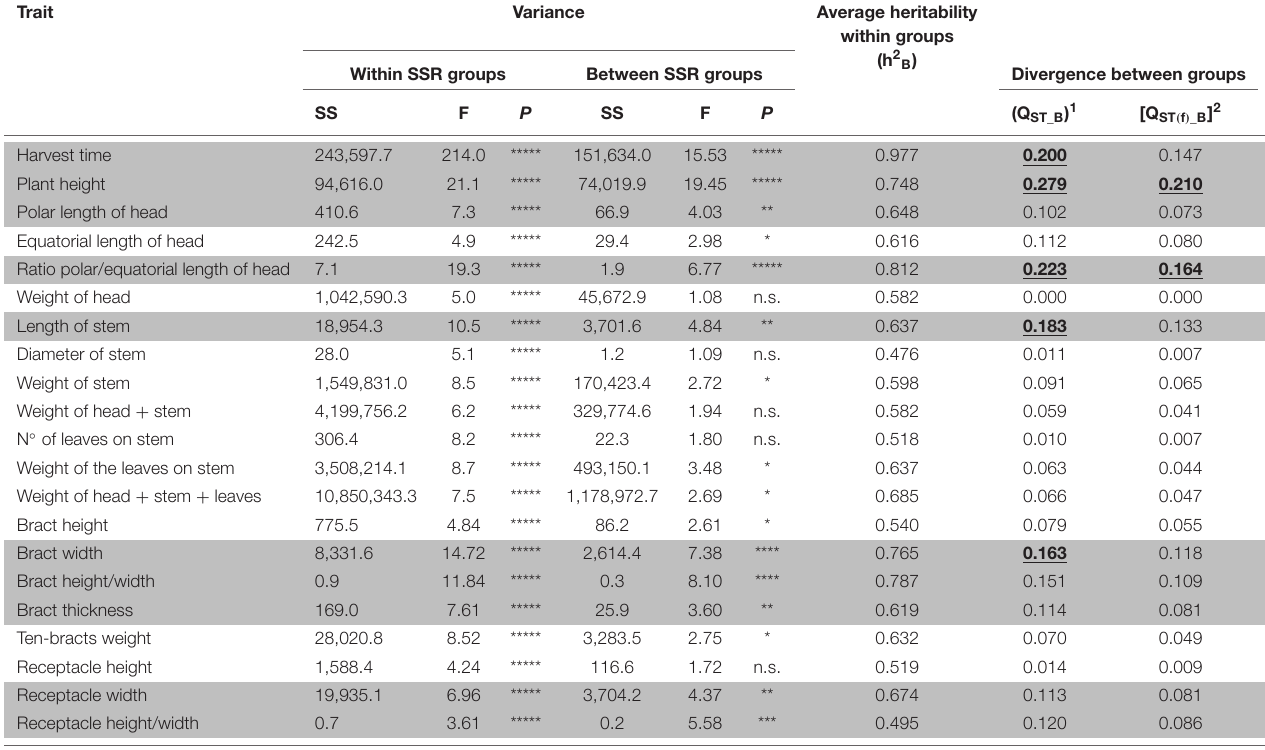
TABLE 3 | Nested Analysis of Variance (NANOVA) to test the significance of the differences among the varieties within the SSR groups and of the differences between the SSR groups for the 21 traits measured at the stage of the harvest of the first head. Trait